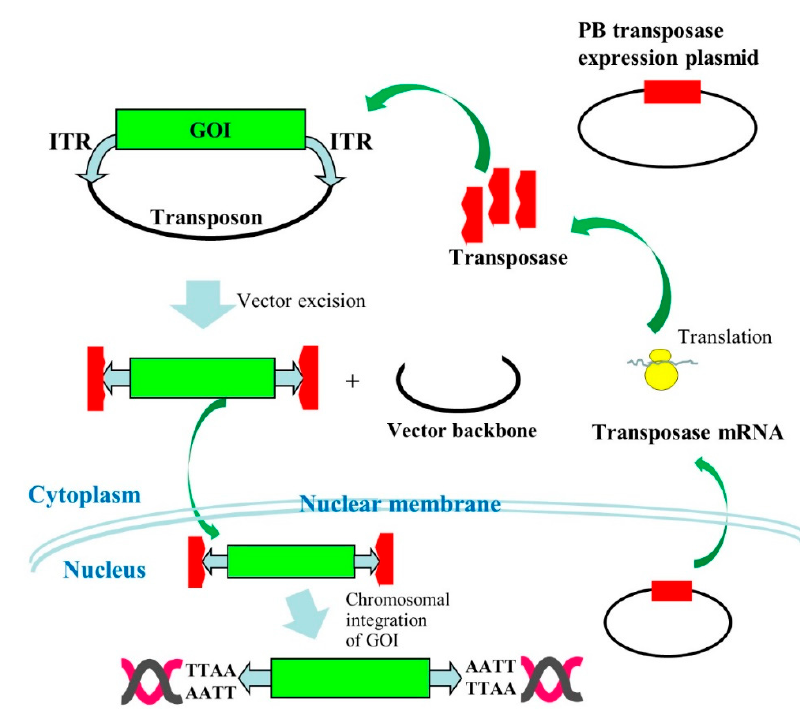
Figure 1. Mechanism of target gene transfer to the host chromosome by the piggy Bac (PB) system is described. A gene of interest (GOI) is engineered so as to be surrounded by the inverted terminal repeat (ITR) in a plasmid backbone. When a transposon carrying the GOI is co-transfected with a PB transposase expression vector into a cell, a part of this exogenous DNA is transferred to the nucleus and PB transposase mRNA is synthesized by the PB transposase expression vector. The resulting PB transposase mRNA is next transferred to the cytoplasm where the PB transposase is synthesized using the mRNA as a template. The synthesized PB transposase specifically binds to the ITR in the transposon vector present in cytoplasm and removes the plasmid backbone. The resulting PB transposase / ITR complex is subsequently transferred to the nucleus where chromosomal integration of the GOI via TTAA consensus sequence occurs.